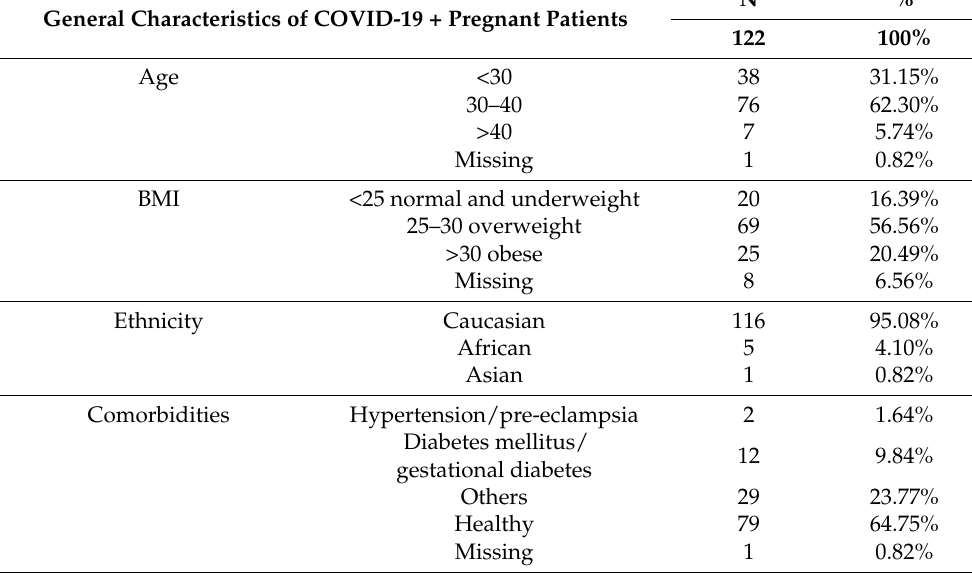
Table 1. General characteristics of the population under study, including age, BMI, ethnicity, co- morbidities, parity, gestational age (G.A.) at COVID-19 diagnosis, COVID-19 symptoms, pregnancy outcome, and mode of delivery. In the case of complete data for a variable, the relative row of “missing data” is not reported. The abbreviations used in the table are the same as in the manuscript. General Characteristics of COVID-19 + Pregnant